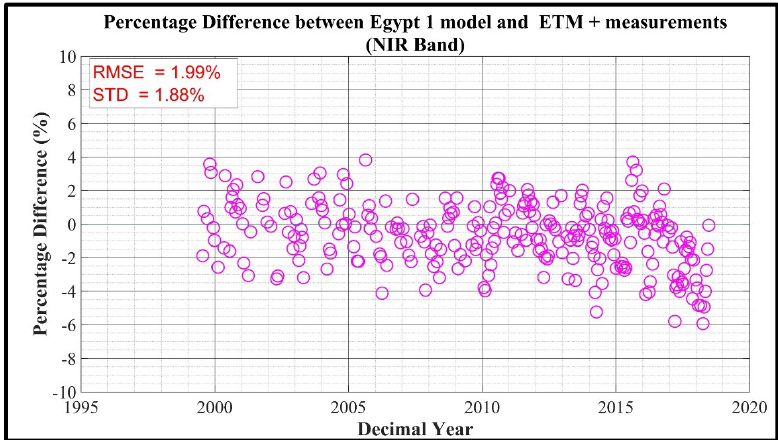
Figure 10. Percentage difference between L7 ETM+ observations and model predictions.